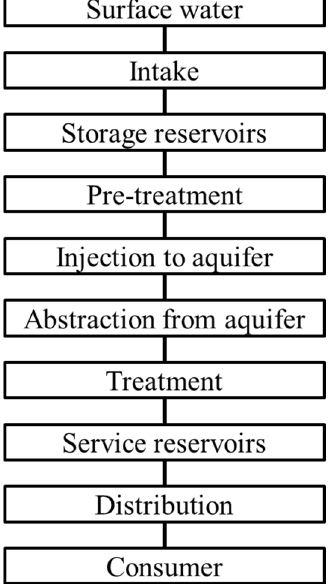
Figure 4. Flow diagram of the drinking water supply process using ASTR.